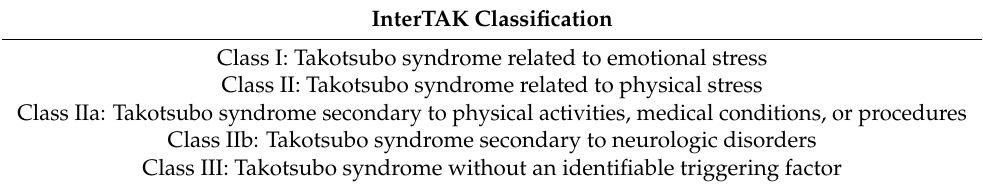
Table 2. InterTAK Classification